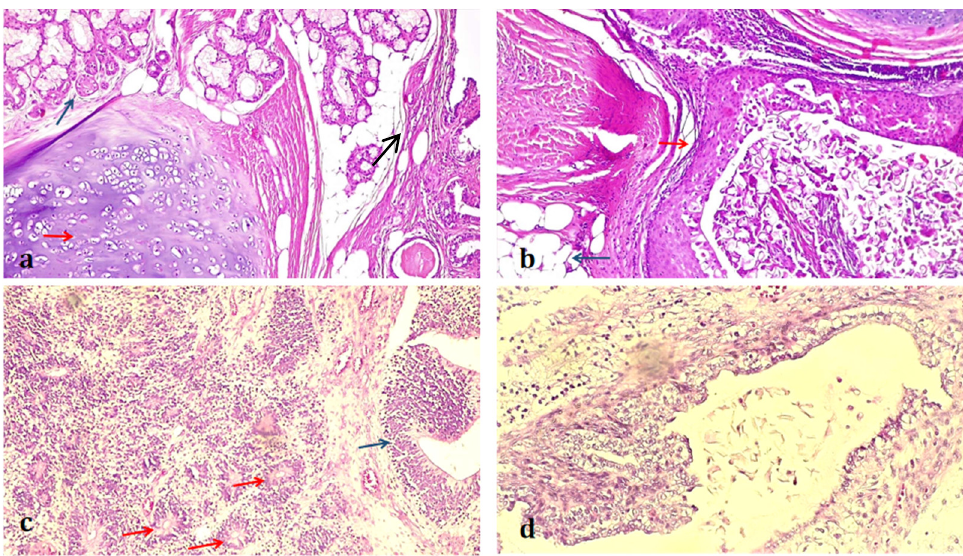
Figure 2. Histological examination revealed a tumor of germ cell origin composed of areas of mature teratoma, immature teratoma, and small areas of yolk sac tumor. ( a ). Teratoma with non-specific glandular tissue (blue arrow) and cartilaginous tissue (red arrow). ( b ). Teratoma shows areas of the dispersed squamous-stratified epithelium (red arrow), adipocytes (blue arrow), and immature smooth muscle cells (black arrow). ( c ). The major component of the tumor consisted of immature teratoma histology, with immature neuroectodermal tissue forming rosettes (red arrows) and tubules (blue arrows). ( d ). Detail of yolk sac component with glandular growth